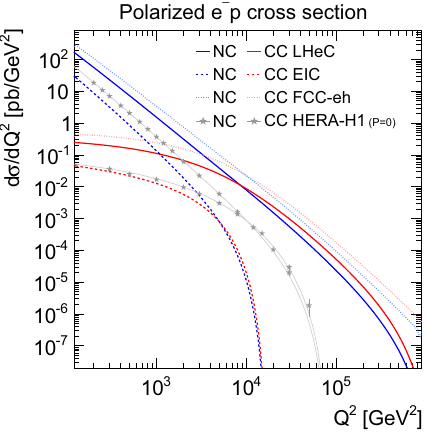
Fig. 1 Single differential inclusive DIS cross sections for neutral- and charged-current e − p DIS with longitudinally polarized electrons ( P e = − 0 . 8)atLHeC,EIC,FCC- eh ,andHERA.ForHERA,unpolarizedcross sections are displayed together with data from the H1